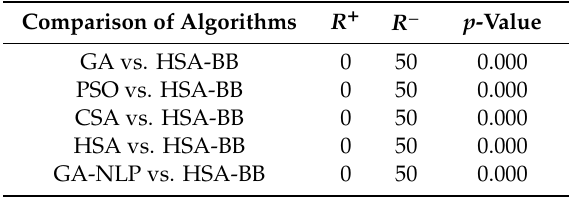
Table 14. Comparative results of the Wilcoxon test of all the